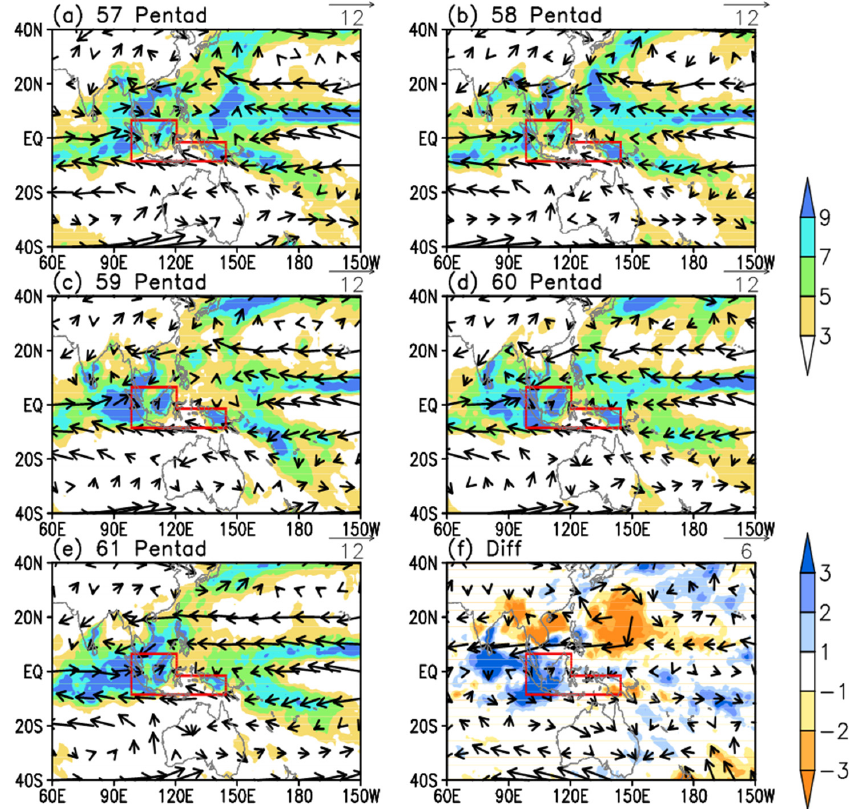
Figure 5. Climatological mean rainfall (GPCP; shading; mm/day) and 850-hPa winds (CFSR; vectors; m/s) for ( a ) 57th pentad; ( b ) 58th pentad; ( c ) 59th pentad; ( d ) 60th pentad; and ( e ) 61st pentad; ( f ) Differences between 60th–61st pentad mean and 57th-58th pentad. The domain of the Maritime Continent is outlined with red boxes.